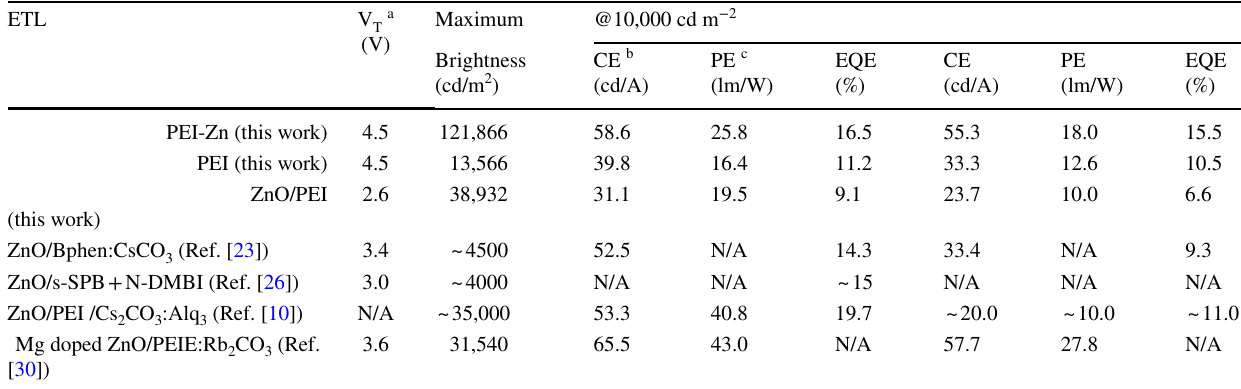
Table 1 Device performances of inverted